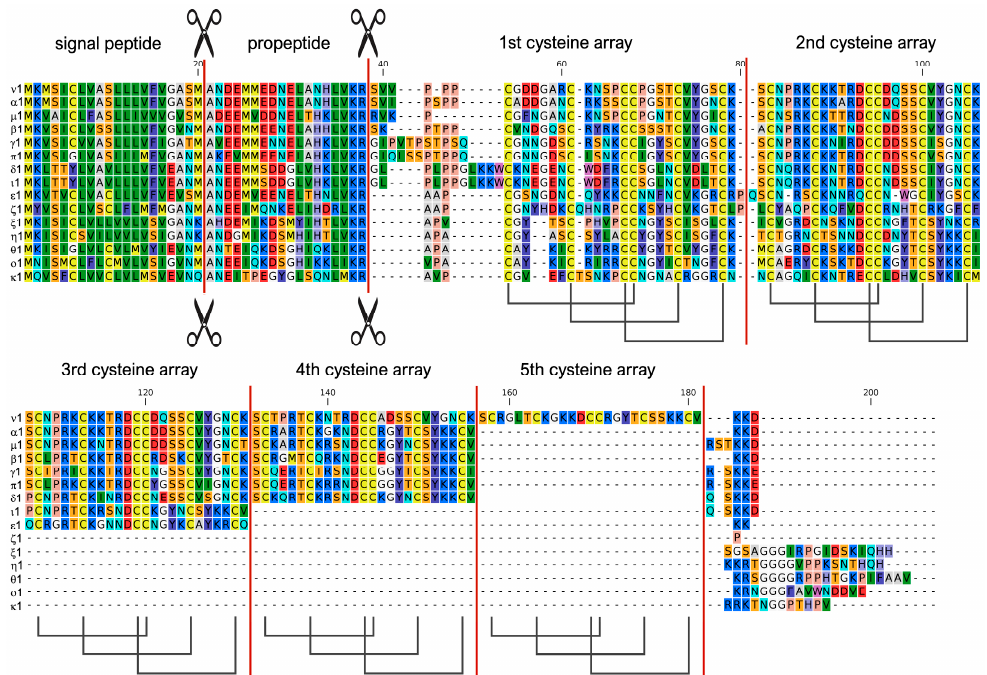
Figure 3. Multiple sequence alignment of the full-length protein precursors of representative members of each of the 15 mCRP-I sequence groups reported in this study (excluding group λ , which entirely lacks conserved cysteine residues). The inferred position of the signal peptide and propeptide cleavage sites are marked by scissors and by a vertical bar, which also indicates the boundaries among the different knottin arrays. The inferred disulfide connectivity between the six highly conserved cysteine residues involved in the establishment of the knottin fold is indicated at the bottom of the mature peptide region.